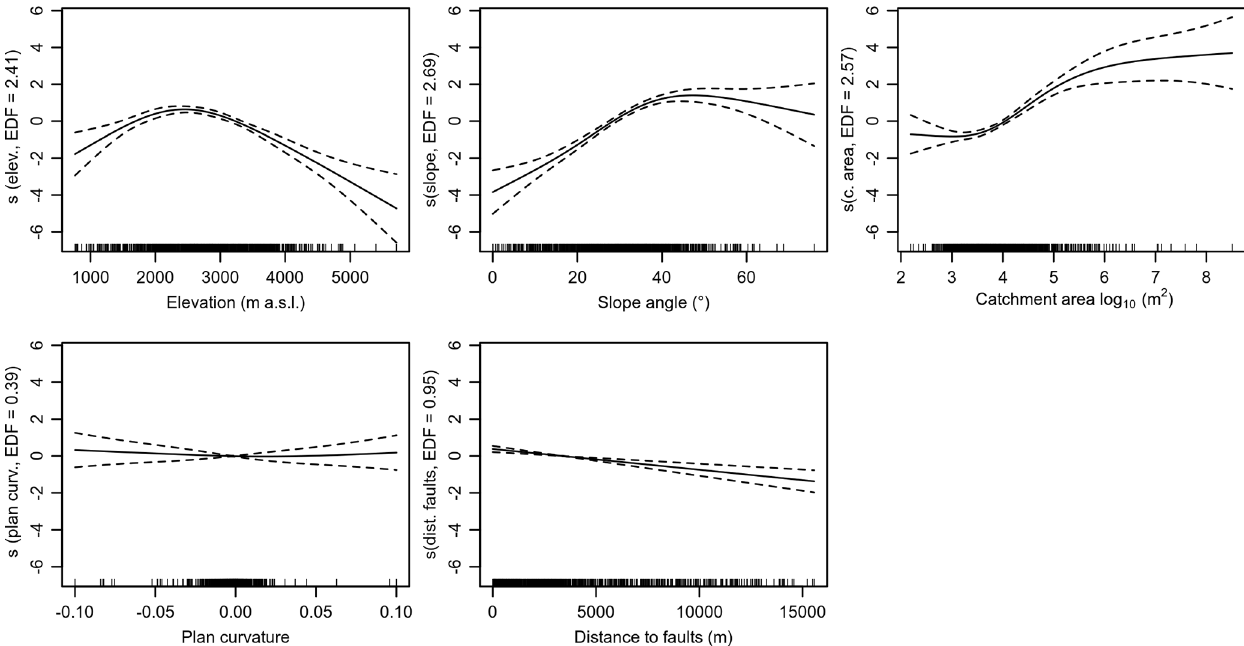
Figure 5. Transformation of predictor variables in the generalized additive model, where the y axis can be interpreted as the associated likelihood (log odds) of being a source area. Terms of the form s(predictor) indicate a nonlinear smoothing spline transformation. The effective degrees of freedom (EDFs) refer to the flexibility of the smoothers. The dashed lines represent confidence bands at a 95%